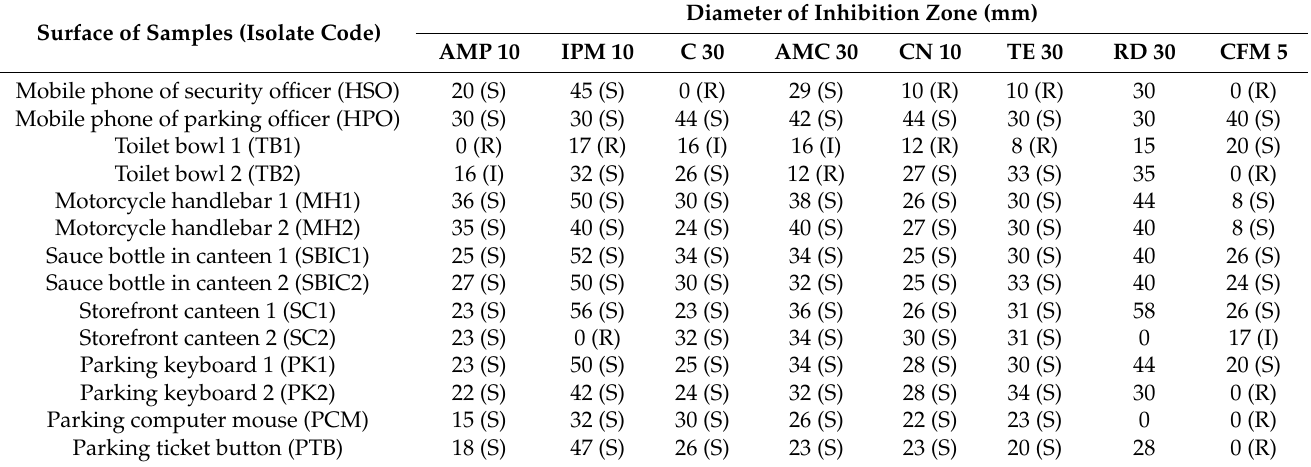
Table 1. Antimicrobial susceptibility testing of bacterial isolates against eight different antibiotics using the disk diffusion